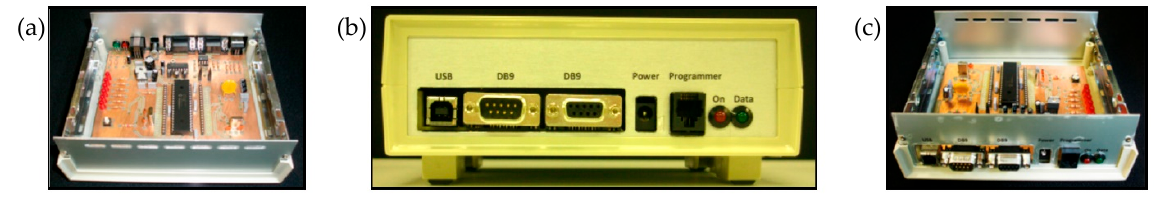
Figure 8. Aspects of the complete system. ( a ) Top view, ( b ) Front view, ( c ) Back view.